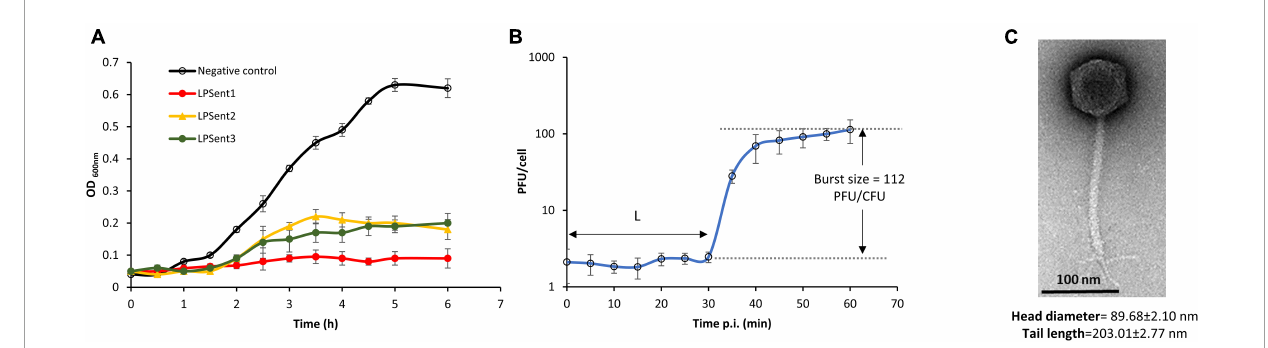
FIGURE2 (A) Lysis ability comparison of the three isolated phages on S . Enteritidis EG.SmE1 as a host at an MOI of 1 in TSB. (B) Growth-kinetics of phage LPSent1 on S . Enteritidis EG.SmE1, phage burst size was calculated as 112 PFU/cell, L refers to the latent period. (C) Transmission electron micrograph of phage LPSent10, scale bar = 100 nm. Data shown in (A,B) are the mean of three replicates and error bars show the standard deviation in the values.